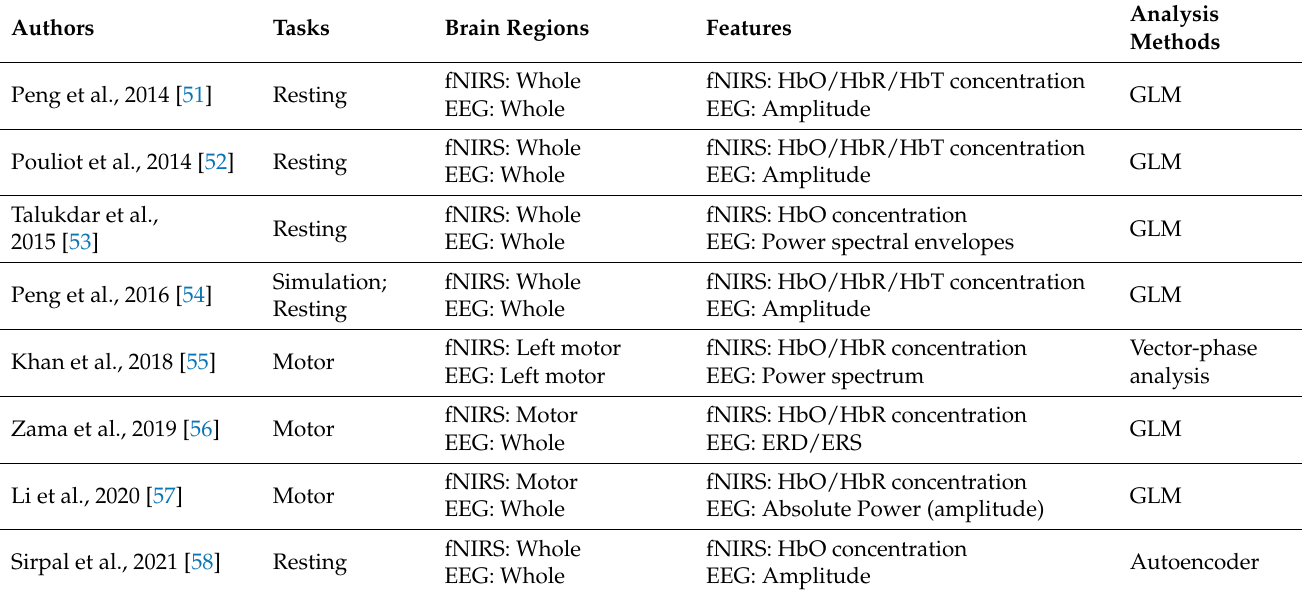
Table 1. Characteristics of studies that performed EEG-informed fNIRS analysis.